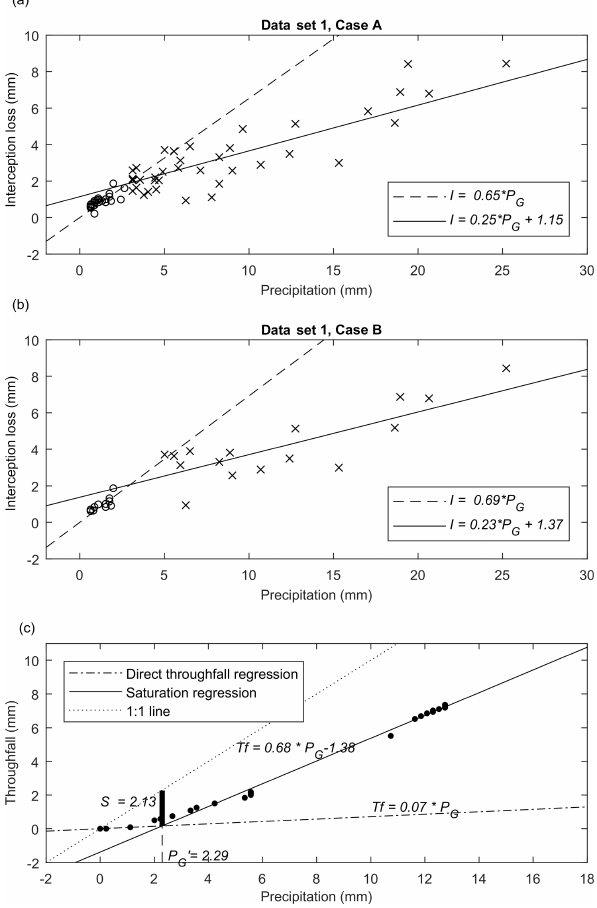
Figure 2. Determination of canopy-related parameters using the mean method and the individual event analysis. (a) Linear regres- sion using data-set 1; events selected in Case A. Circles represent rainfall events with total rainfall less than that necessary for satu- ration; crosses represent data with enough rainfall to saturate the canopy. (b) Linear regression using data-set 1; events selected in Case B (similar legend to a ). (c) Individual event analysis (IEA) on 17 September 2015, the plot of data used to estimate canopy di- rect throughfall and saturation storage capacity. Dots represent val- ues of cumulative rainfall vs. cumulative Tf . The direct throughfall regression equation was Tf = 0.07 P G , and the saturation regres- sion equation was Tf = 0.68 P G − 1.38. Canopy saturation point was calculated as the intersection of the two linear regressions, = P (cid:48) G